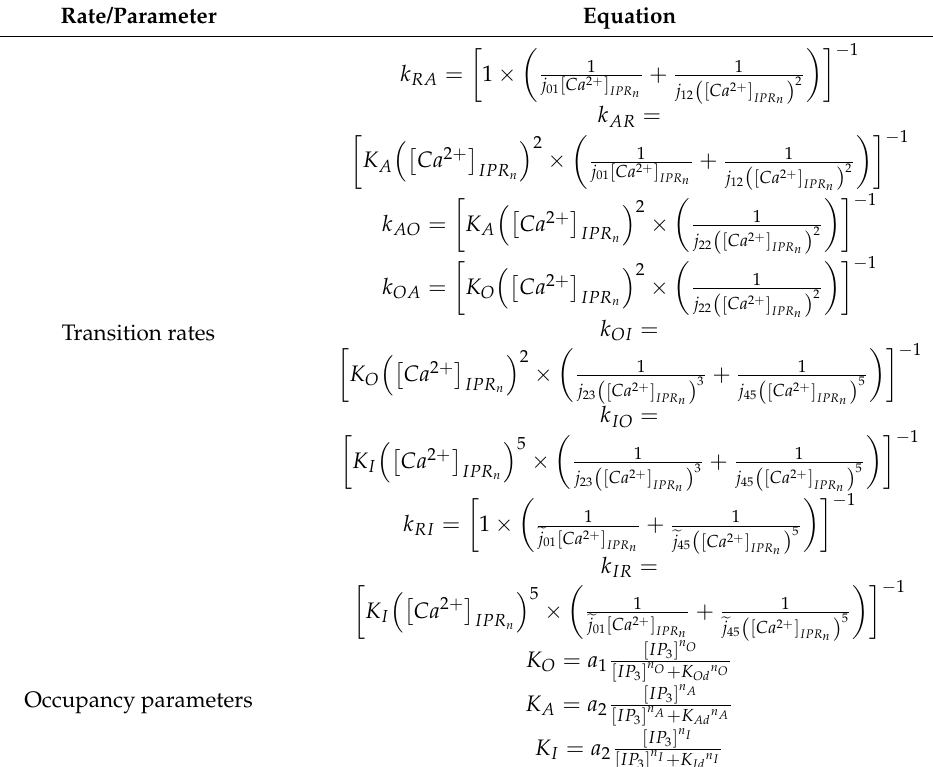
Table 5. Transition rates used in the IP 3 R model.